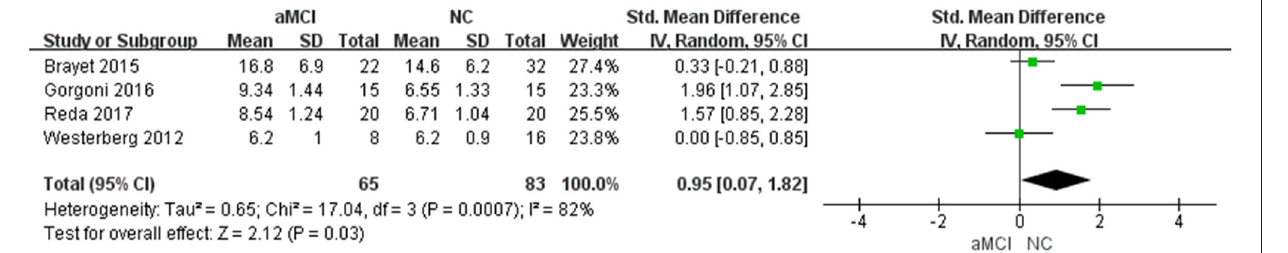
FIGURE 5 | Meta-analysis of N1% between the aMCI and NC